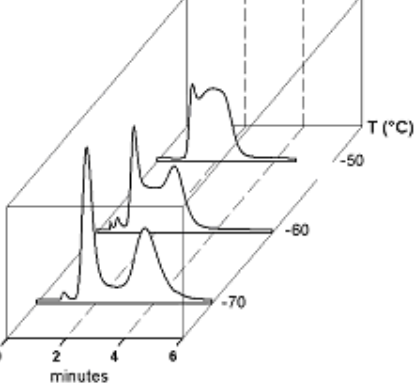
Figure 4. DHPLC traces of a tertiary amide in the form of variable temperature HPLC.